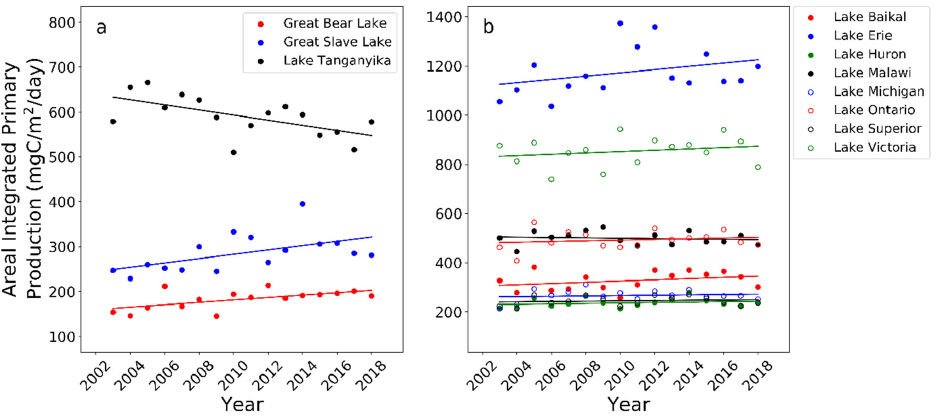
Figure 3. Annual production plotted over the 16 year study period (2003–2018) along with their OLS- derived trend lines. Panel a shows data and trends for Lake Tanganyika, Great Bear Lake, and Great Slave Lake, each of which had either a significantly increasing or decreasing trend. Panel b shows the data and trends for the other 8 lakes.